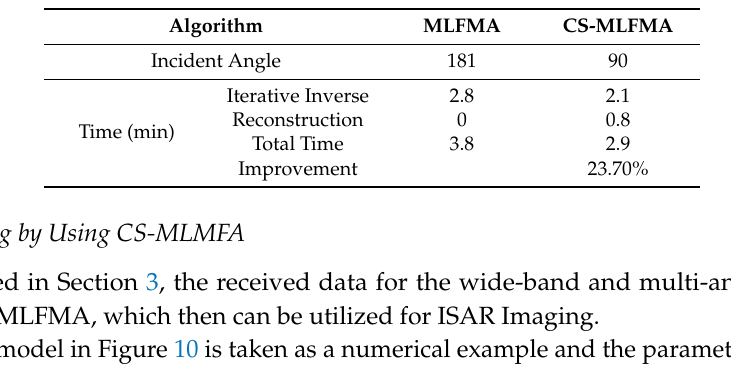
Figure 9. RCS for ship model by MLFMA and CS-MLFMA. Table 2. Computation time comparison for ship model.